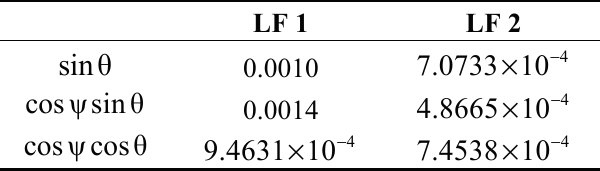
Table 1. RMS error of the attitude